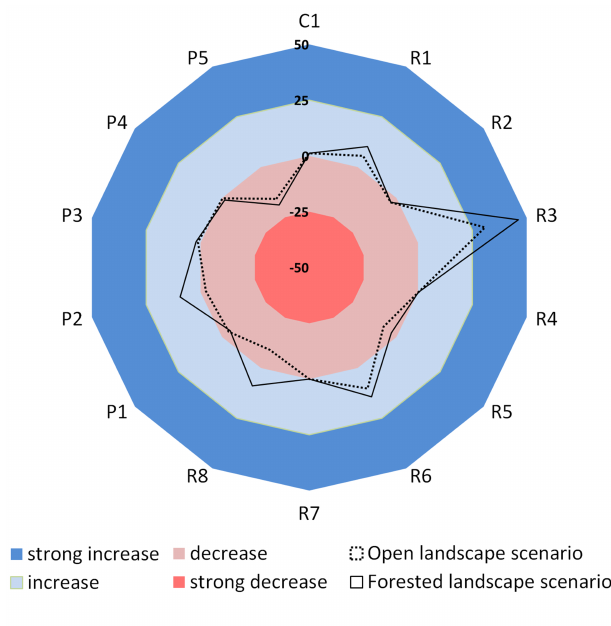
Fig. 2 . Impact of two different wetland restoration/creation scenarios for the Flanders region. Scores are derived as the difference of total ecosystem service supply between scenarios and the current situation (driven by surface area